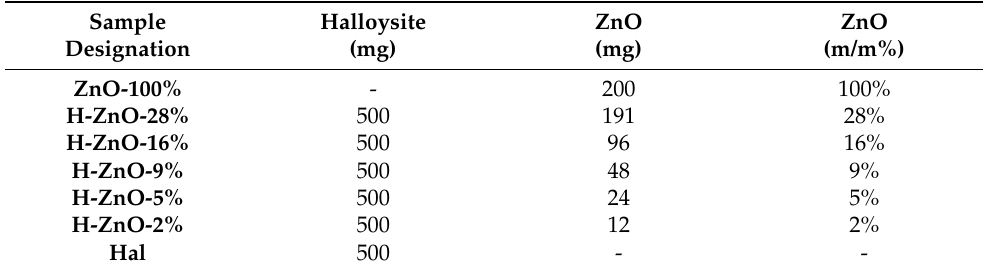
Table 1. Designation and composition of